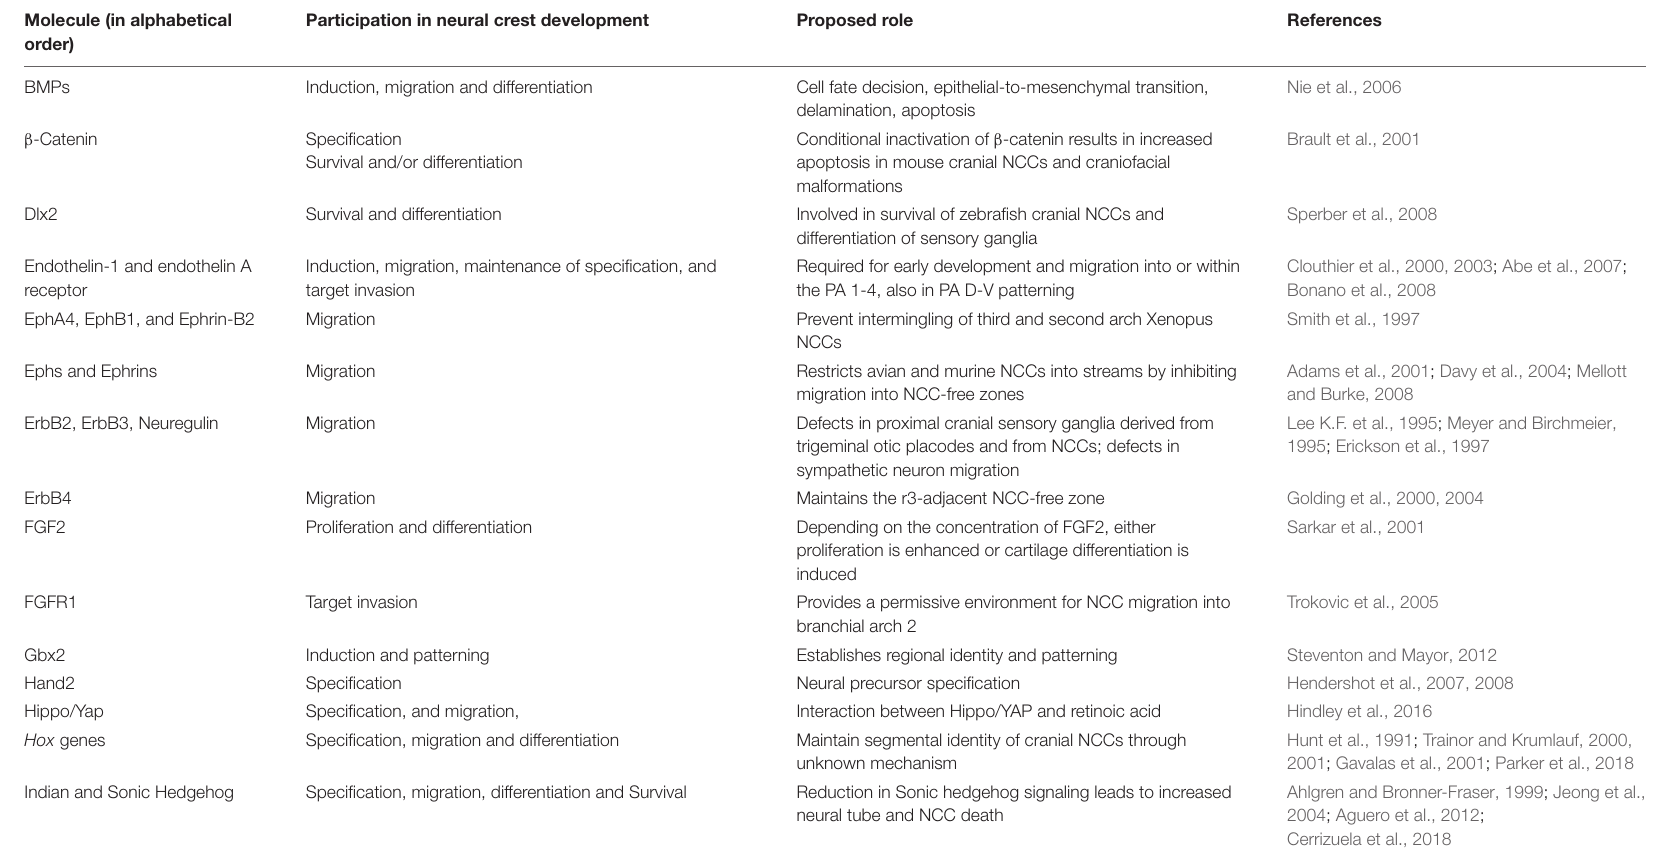
TABLE 2 | Cues required for development of NCCs are NC-derived cranial nerves. Molecule (in alphabetical